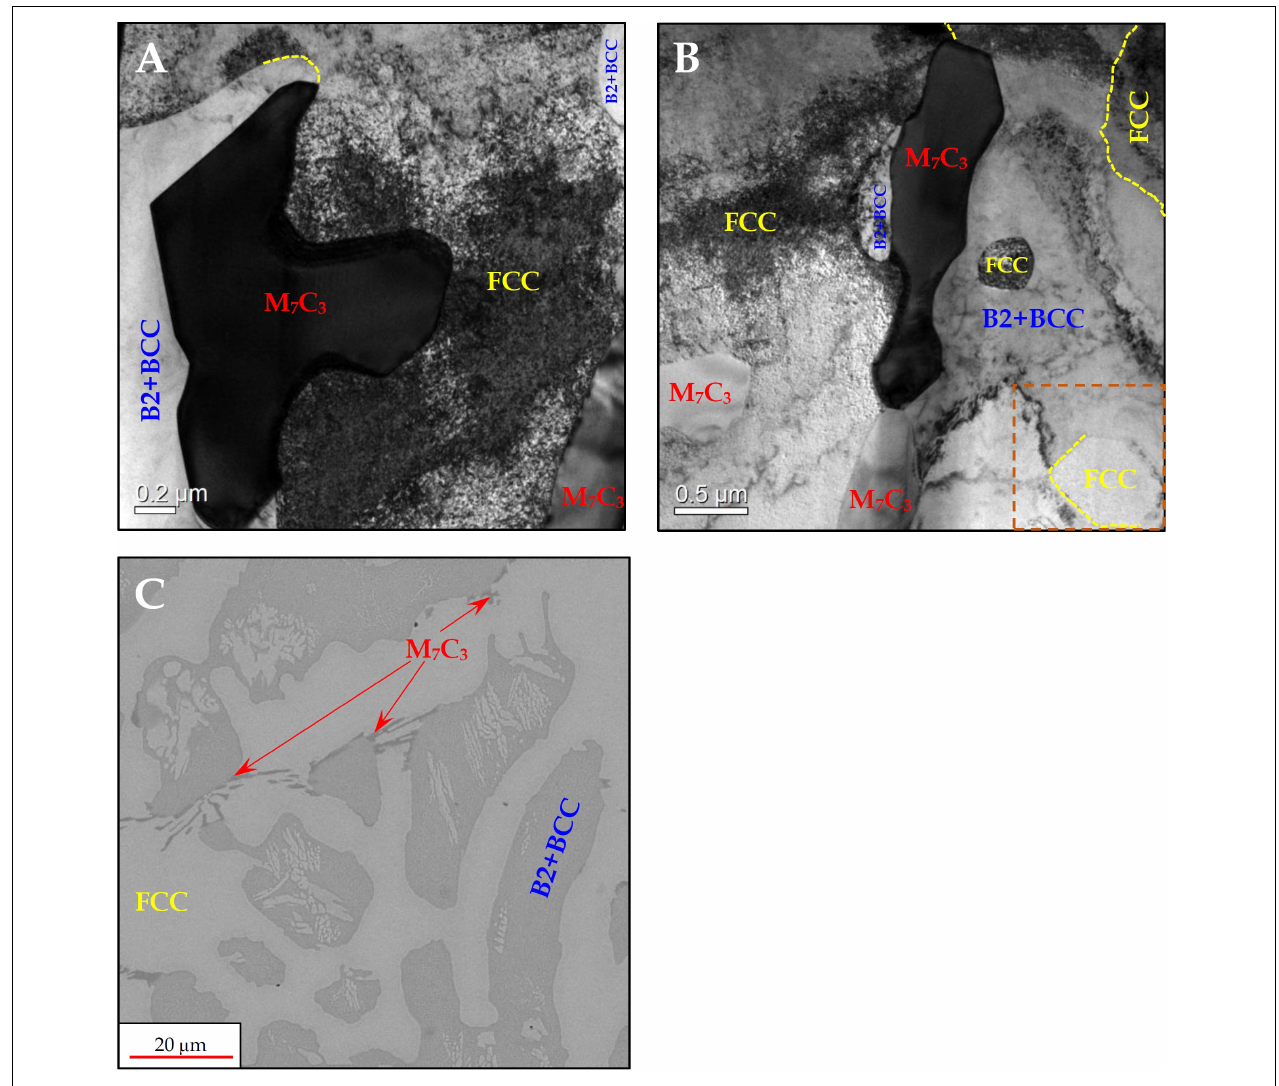
FIGURE 1 | BF-TEM micrographs showing the general morphology of the phases comprising the microstructure in as-cast AlCrFe 2 Ni 2 alloy (A,B) . HRSEM micrograph showing the general microstructure in as-cast AlCrFe 2 Ni 2 alloy (C).